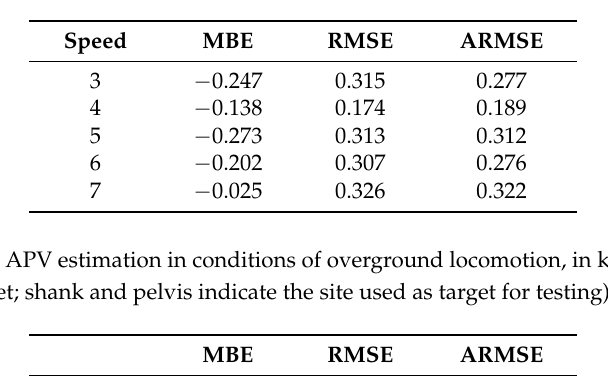
Table 7. Statistics of APV estimation for different treadmill speeds, in km/h (training done using the OW dataset, target: shank APV REF ).